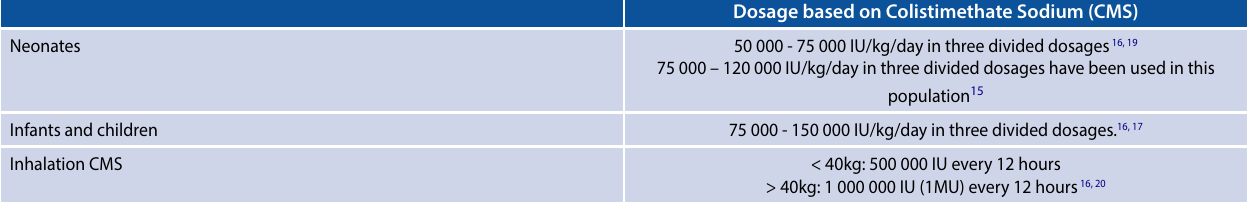
Dosage based on Colistimethate Sodium (CMS)